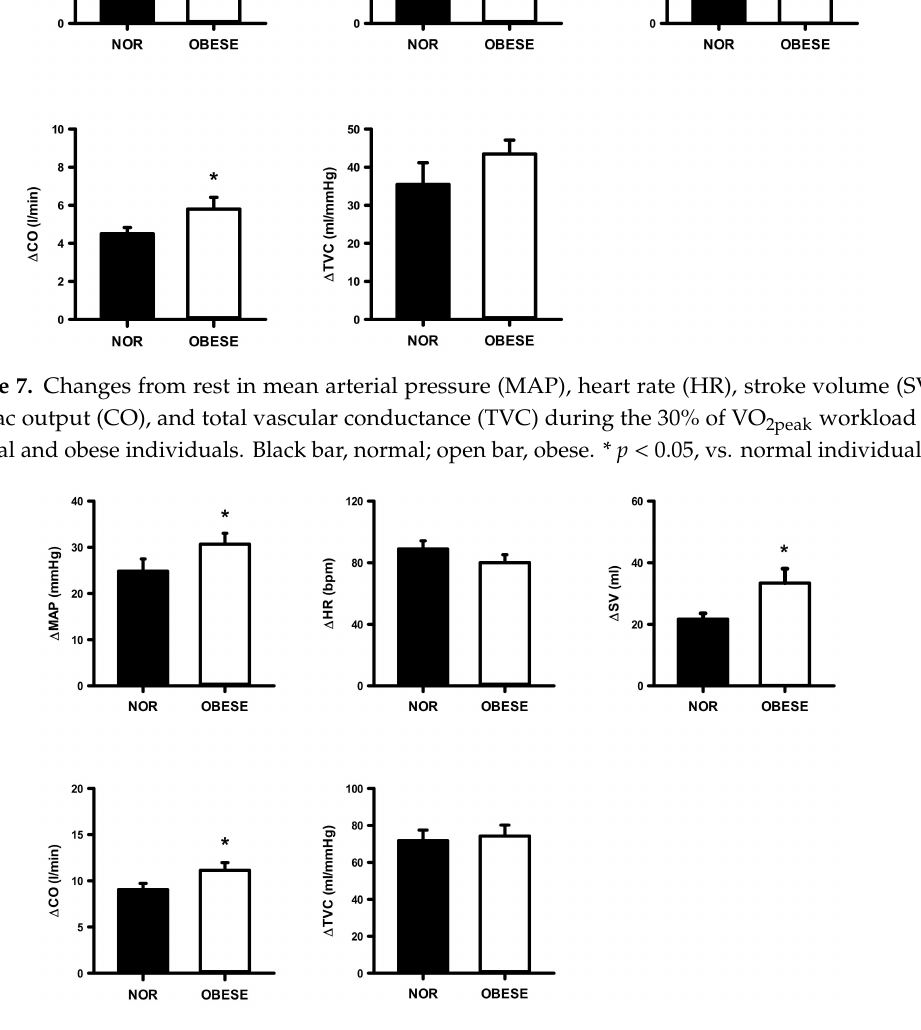
Figure 8. Changes from rest in mean arterial pressure (MAP), heart rate (HR), stroke volume (SV), cardiac output (CO), and total vascular conductance (TVC) during the 60% of VO 2peak workload in normal and obese individuals. Black bar, normal; open bar, obese. * p < 0.05, vs. normal